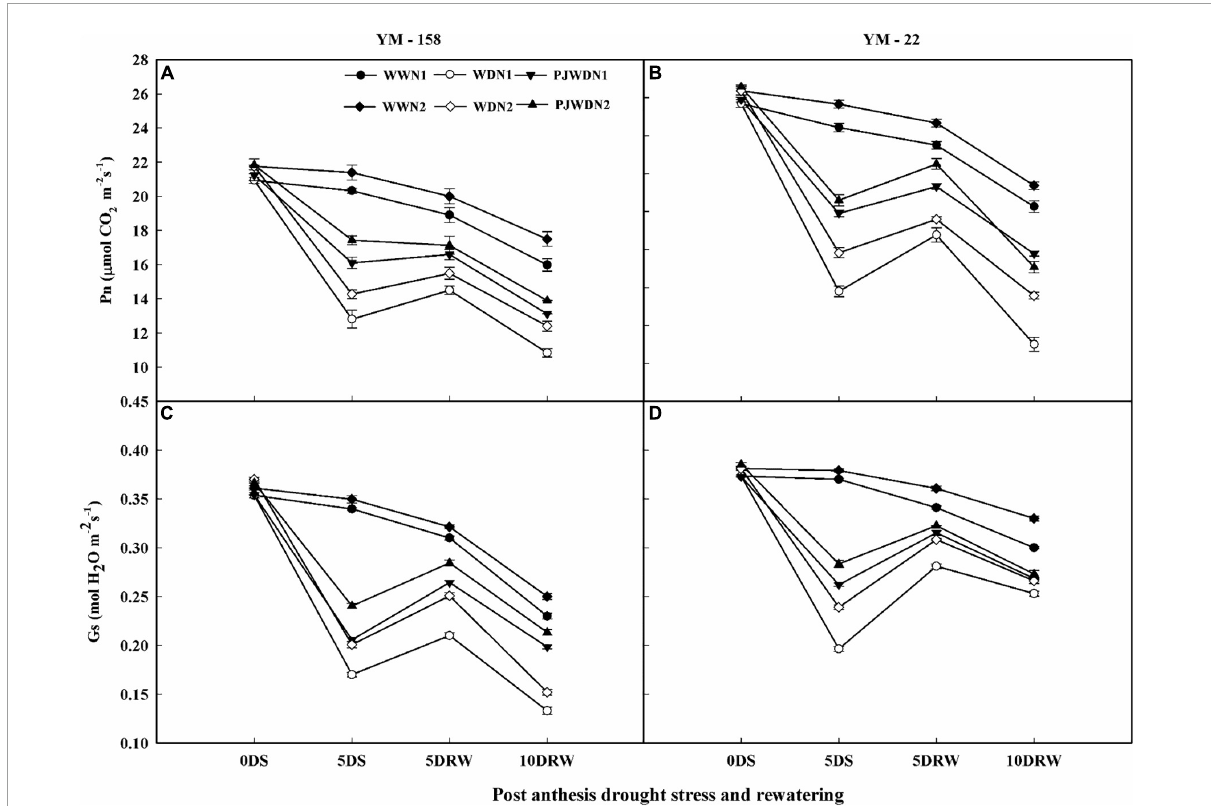
FIGURE3 Effects of pre-drought priming on net photosynthetic rate (Pn) and stomatal conductance (gs) in response to post-anthesis drought stress under two nitrogen (N) rates (N1,180 and N2, 300) in Yangmai-158 (A,C) and Yangmai-22 (B,D) wheat cultivars. Treatments: WW (control), no priming at jointing + no post-anthesis drought stress; PJWD, priming at jointing + post-anthesis drought stress; and WD, no priming at jointing + post-anthesis drought stress. Pre-drought priming was completed during the jointing stage, and post-anthesis drought stress was applied from 7 to 14 days after anthesis. The horizontal axis shows the time course of the sampling: 1 day before drought stress (0DS), 5 days after drought stress (5DS), and 5 and 10 days after re-watering (5DRW and 10DRW). Each vertical bar above the mean value indicates the standard error of three replicates ( n = 3) by using three-way ANOVA at P <